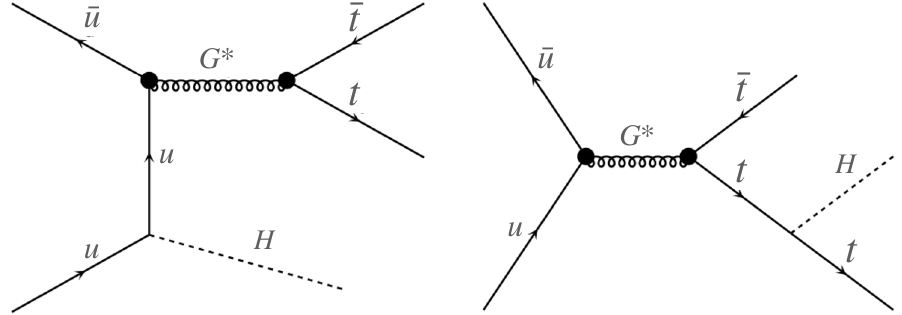
Figure 11 . A representative subset of Feynman diagrams of the process pp → t ¯ tH mediated by a KK gluon. These are only two of the 16 diagrams containing a KK gluon out of a total of 116 involved in the